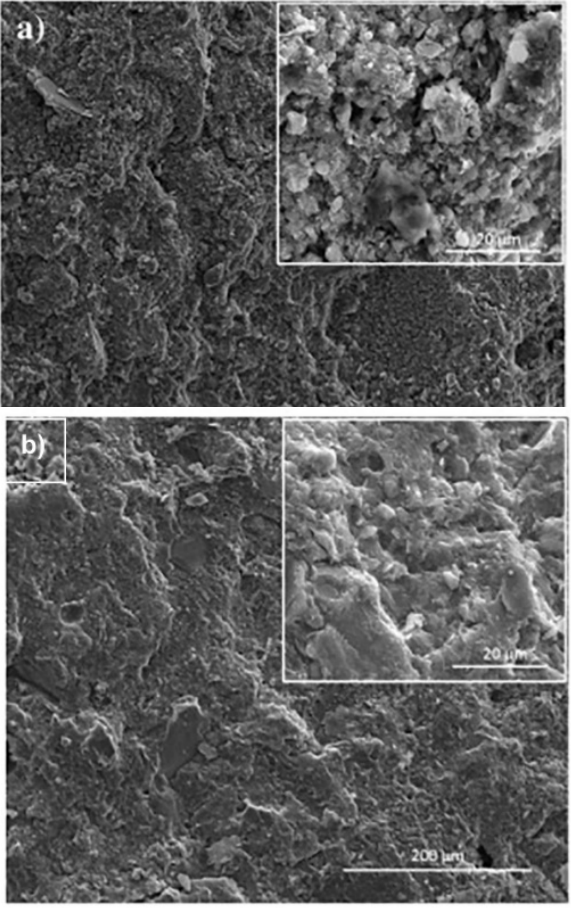
Figure 3: Atomic diagram of kaolinite (two layers), Image generated in VESTA (Larsen et al., 2017), using structural parameters from Bish (Bish, 1993).